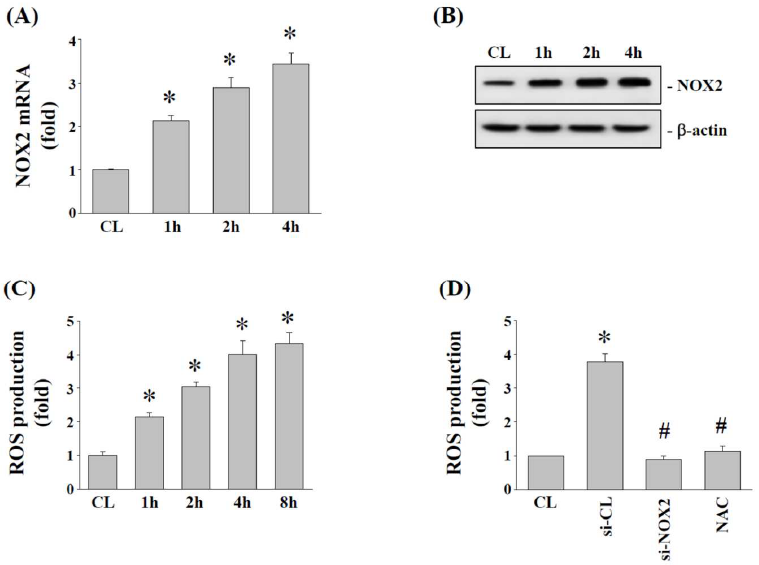
Figure 3. HCS induces NOX2 expression to trigger ROS generation. ( A , B ) HAFCs were exposed to 15% HCS for the indicated times, and the expression levels of NOX2 mRNA ( A ) were determined by real-time PCR analysis. The protein expressions of NOX2 were determined by Western blot analysis ( B ). Bars in ( B ) are the mean and SEM fold change in band density relative to control, normalized to total protein levels from three independent experiments. ( C ) HAFCs were kept as the controls or were exposed to 15% HCS for the indicated times, and then the intracellular ROS level was examined. The results in ( A , C ) are mean ± standard error of the mean (SEM). * p < 0.05 versus CL. ( D ) HAFCs were kept as CL or exposed to 15% HCS. Before being kept as CL or exposed to stretch, HAFCs were transfected with control siRNA (si-CL), a specific siRNA of si-NOX2, or pretreated with NAC (ROS scavenger) for 1 h and then exposed to 15% HCS for 8 h, then the intracellular ROS level was examined. The results are shown as mean ± SEM. * p < 0.05 vs. CL. # p < 0.05 versus si-CL with 15% stretch